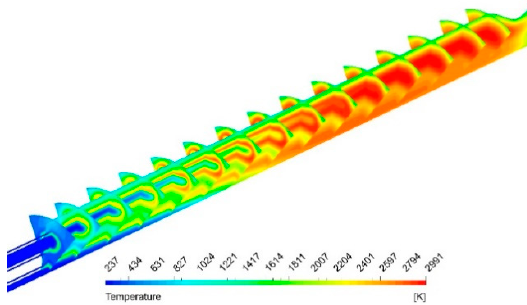
Figure 12. The P1 Gray model temperature field (50% axial scaling).